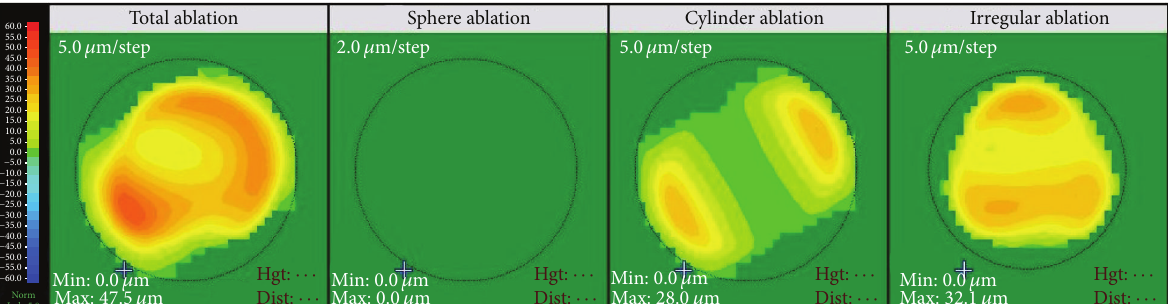
Figure 6: The ablation profile in CATz (Quest, Nidek excimer laser